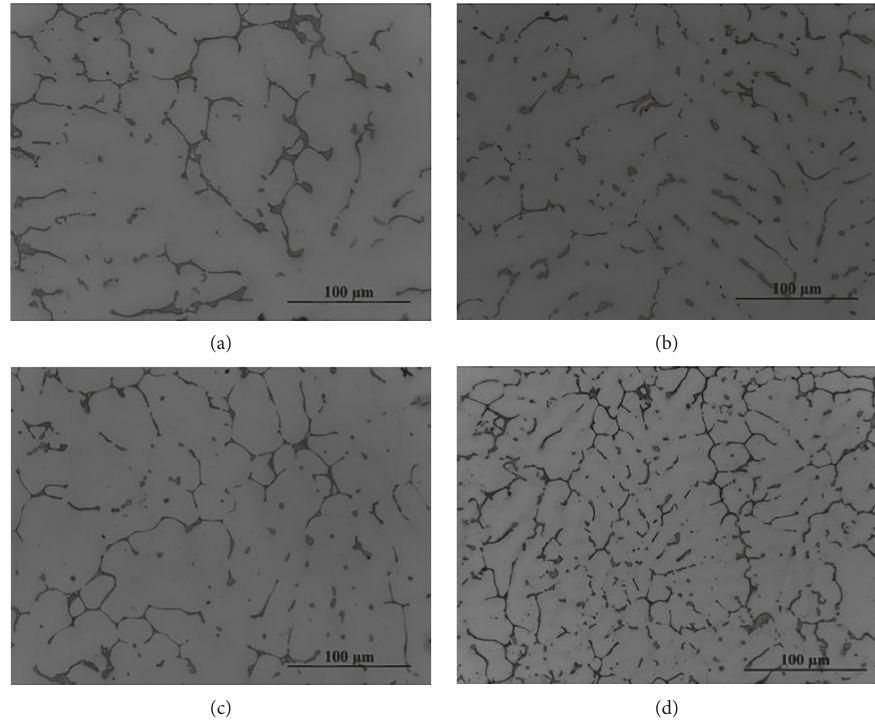
Figure 1: Optical micrographs of the as-cast Mg-Zn-Gd(-Ca) alloys: (a) Mg-7.2Zn-2.4Gd, (b) Mg-7.2Zn-2.4Gd-0.16Ca, (c) Mg-7.2Zn- 2.4Gd-0.32Ca, and (d) Mg-7.2Zn-2.4Gd-0.64Ca.